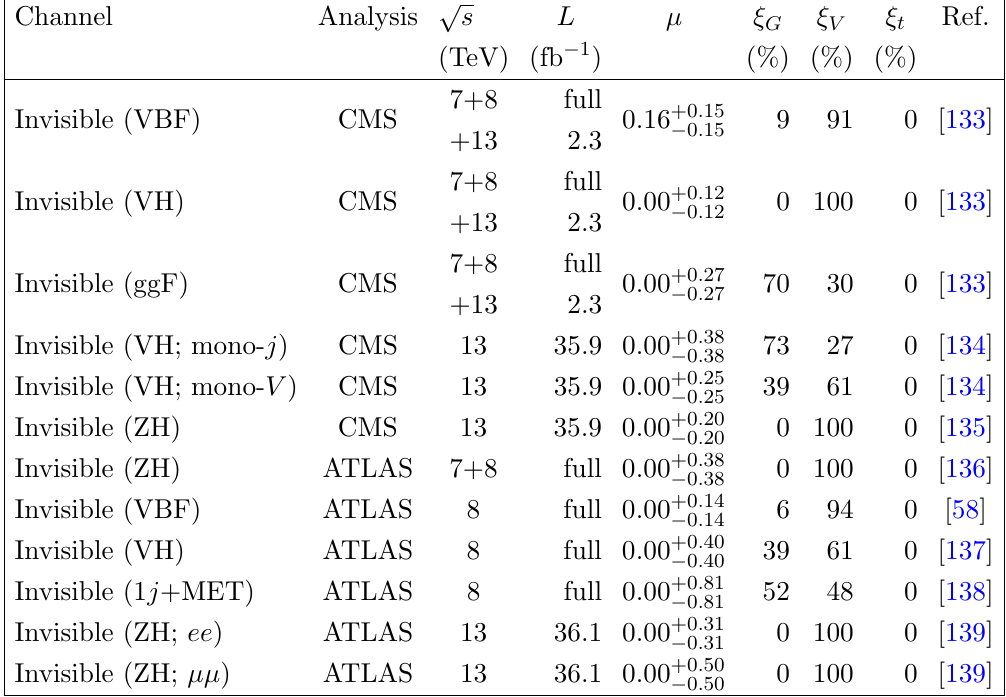
Table 3 . Signal strengths for Higgs invisible searches (cid:22) strengths and 1 (cid:27) error bars are used if the likelihood curve is provided. Otherwise we assume the observed signal strength is 0 and translate the 95% upper limits on signal strength, (cid:27) 95% error bars ( (cid:27) up/down